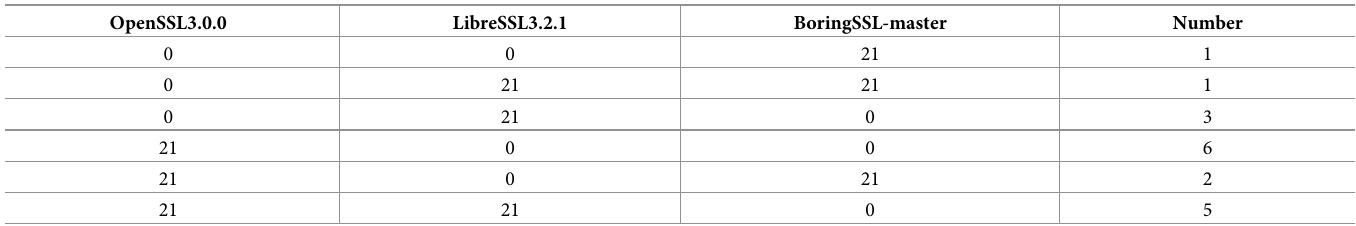
Table 4. The detailed number of discrepancies for the “new” version. OpenSSL3.0.0